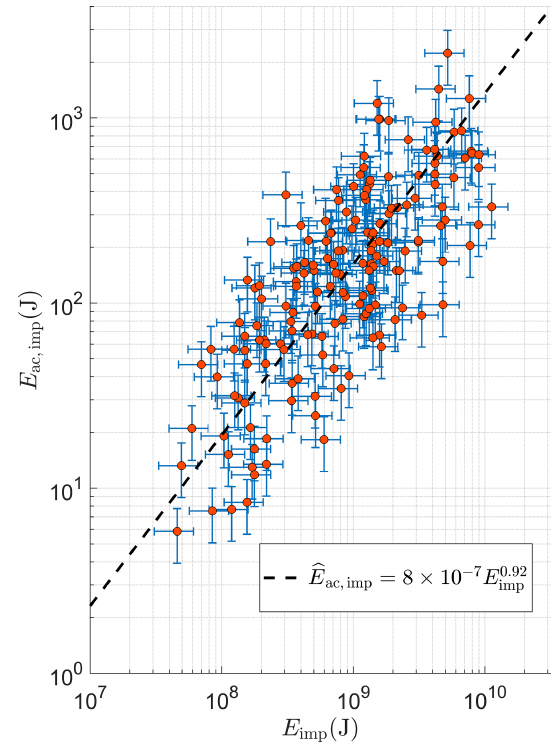
Figure 7. Relationship between the block–water impact energy and underwater acoustic emission below 100Hz. Uncertainties are marked with blue whiskers and were estimated to be 33% for both variables. The remaining scatter in impact energy is most likely caused by different calving styles and an associated variability in source mechanisms. The results with inclusion of outliers are shown in Fig. S6 in the Supplement (see text for